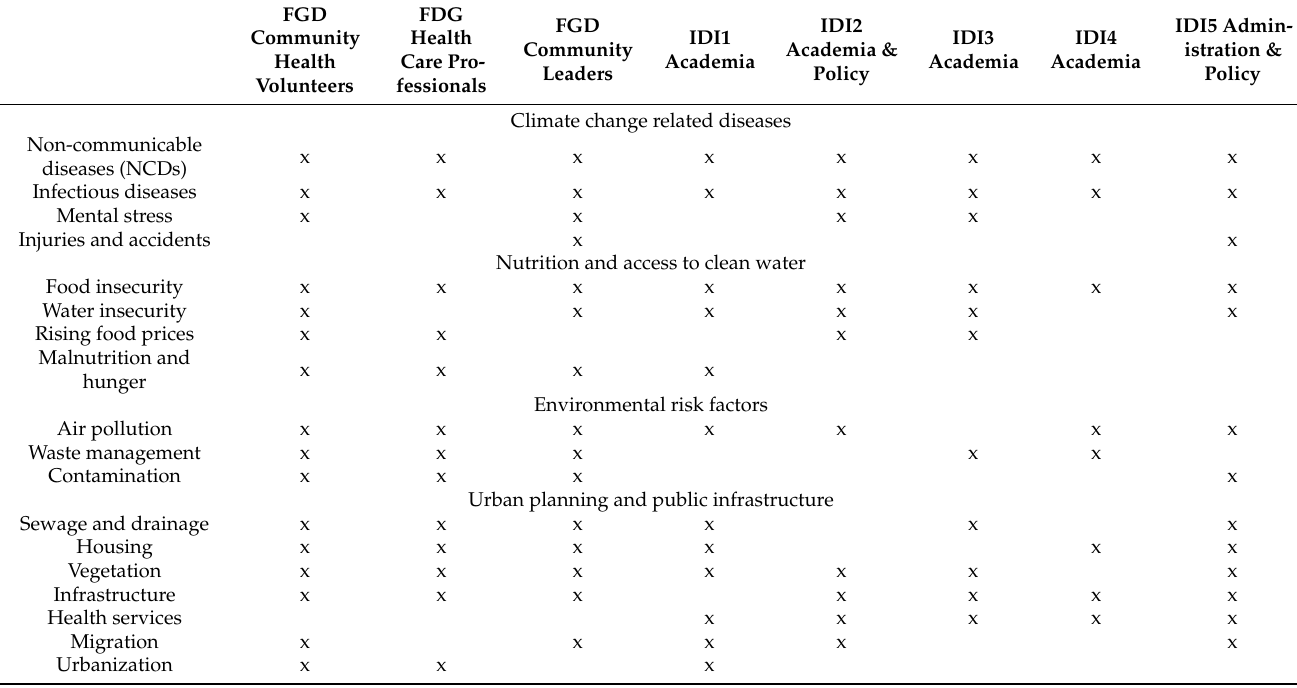
Table 2. Sub-themes represented across interviews (FGDs and